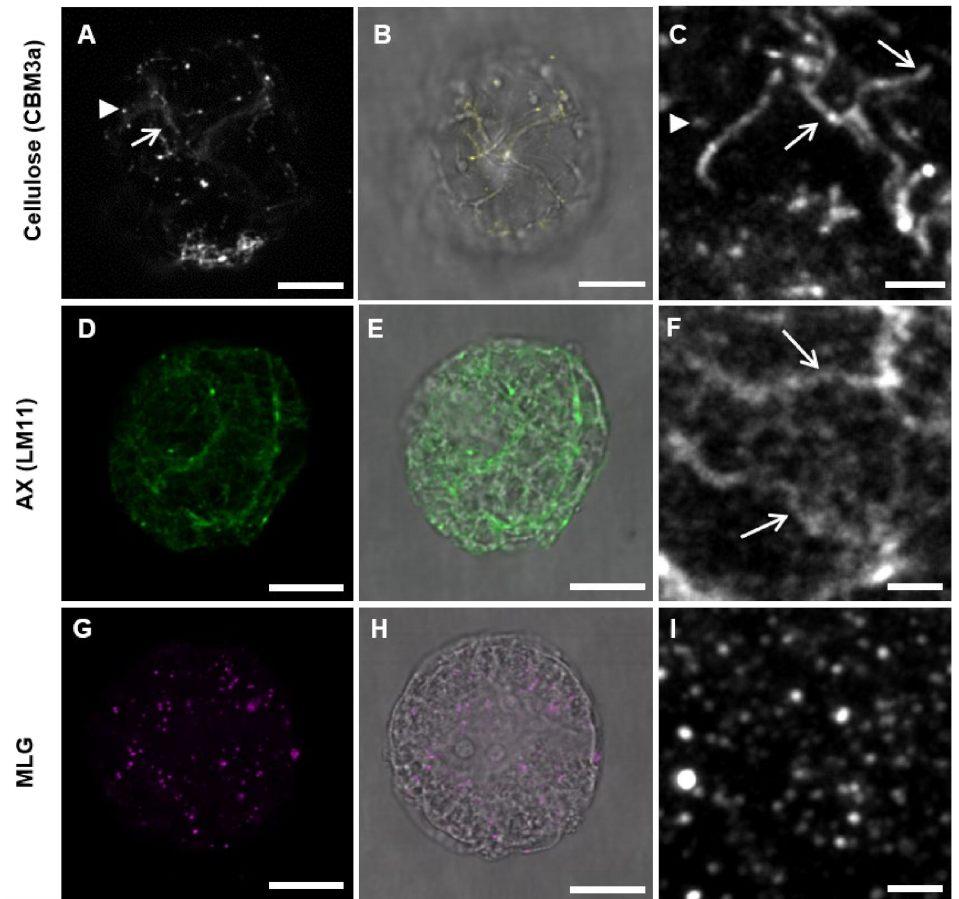
Figure 7. Lolium SCC protoplasts treated with 200 nM isoxaben for 24 h prior to fixation and antibody labeling. ( A , B , D , E , G , H ) whole cell images. ( C , F , I ) are higher magnification images of cell wall labeling. The pattern of label- ing of crystalline cellulose with CBM3a ( A – C ) appeared to be disrupted with possibly terminated filaments (arrows) and only partial coverage of cellulose labeling over the cell. Punctate dots were present (arrow heads). Labeling of AX using LM11 ( D – F ) was less disrupted. Filamentous-like structures of AX (arrows) were still present and the amount of labeling appeared to be similar to untreated cells. The punctate pattern of MLG labeling ( G – I ) looked similar to cells with no treatment. Scale bars: A – B , D – E , and G – H = 5 µ m, and C , F , and I = 2 µ